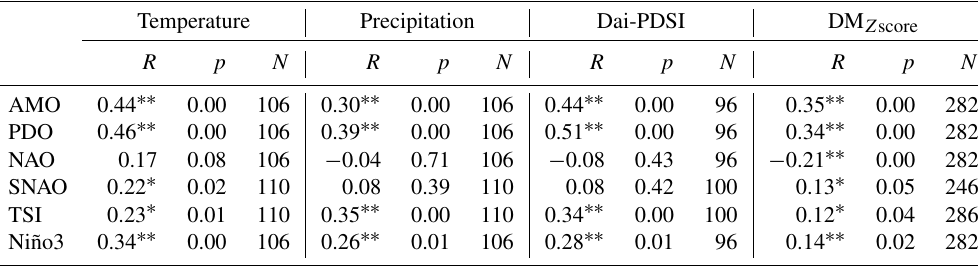
Table 6. Correlation coefficients between the large-scale climate indices (AMO, PDO, NAO, SNAO, TSI and Niño3) and the local annual mean temperature, total precipitation and instrumental Dai-PDSI, as well as the Z score of dry–wet variation in the Daxing’an Mountains (DM Z score